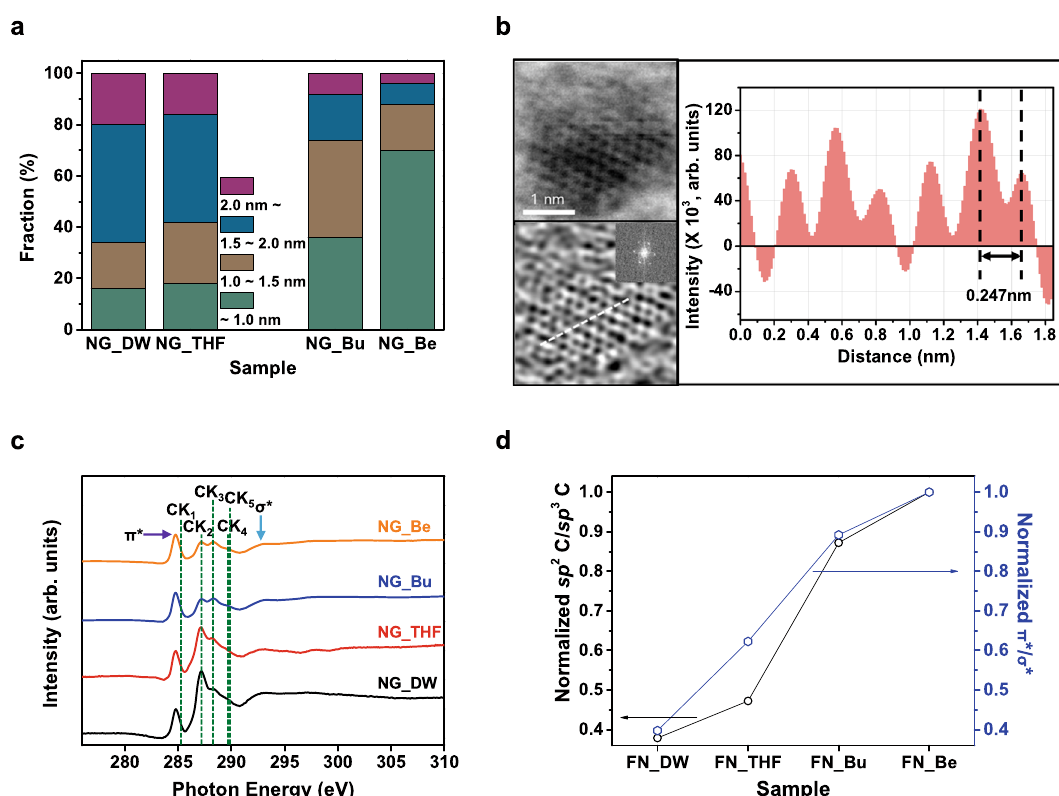
Fig. 3 Morphological and structural characterizations of NGs. a AFM-measured height distributions of NGs (collected at 50 dots per each sample). b Representative STEM image (top-left), corresponding IFFT image of a selected area (bottom-left, inset: FFT image), and intensity line pro fi le (right) along the dashed line of NG_Be (atom distance of ~0.24nm, matching with average distances in graphitic materials (1120)) 25 . c NEXAFS spectra of four different types of NGs. The lowest energy resonance, at ~285.2 eV, corresponds to the transition of C 1 s core-level electrons into states of π * symmetry around the M and L points of the graphene Brillouin zone above the Fermi level, whereas the higher energy peak at ~293.2 eV can be attributed to the excitation of C 1 s core electrons into dispersionless states of σ * symmetry 46,47 . A more detail description is presented in the Method section. d Ratios of sp 2 C – C/ sp 3 C – C (black circle) and I σ * /I π * (blue hexagon) in NGs prepared in different reaction